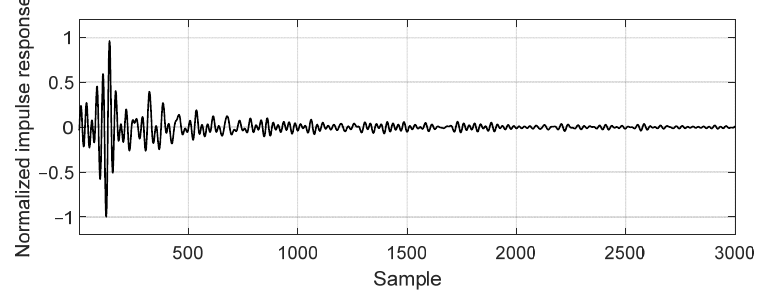
Figure 8. Impulse responses of the secondary path model.